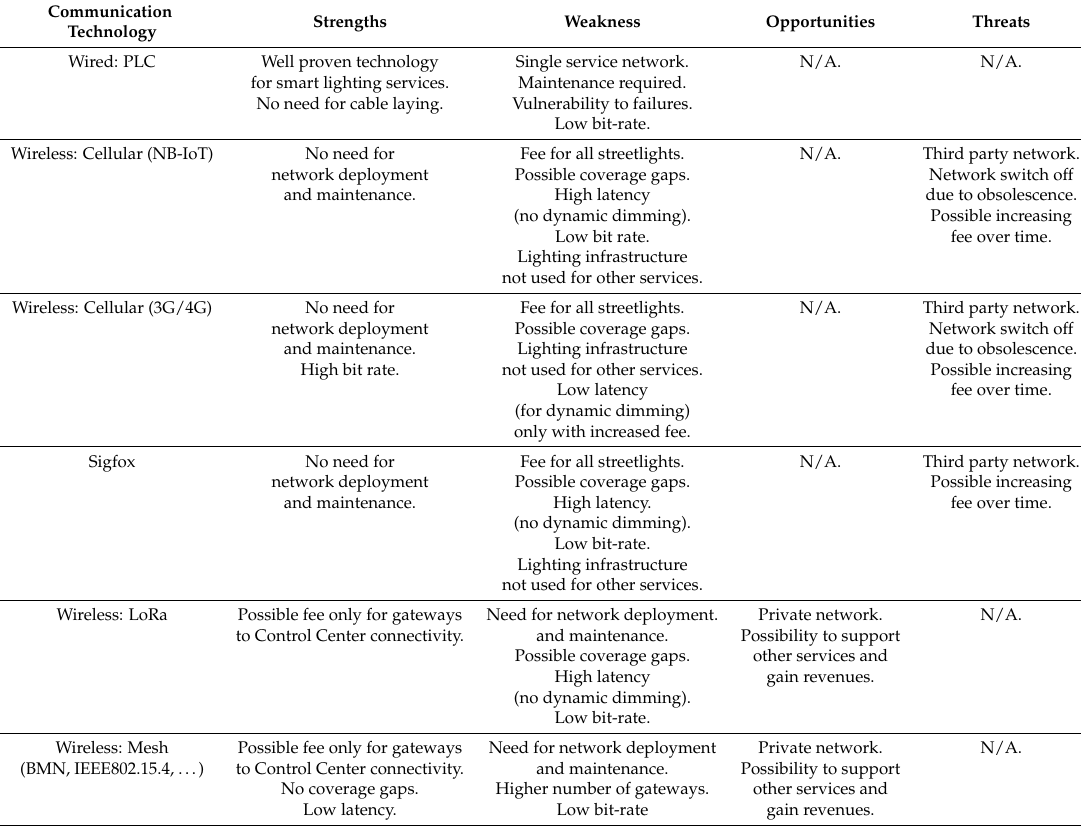
Table 1. Communication networks. SWOT analysis (strengths, weakness, opportunities,